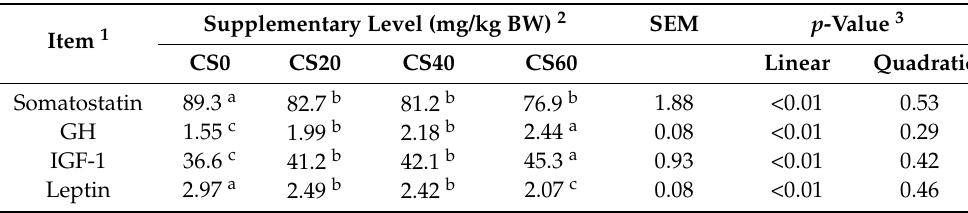
Table 3. Effect of dietary CS addition on serum hormones.